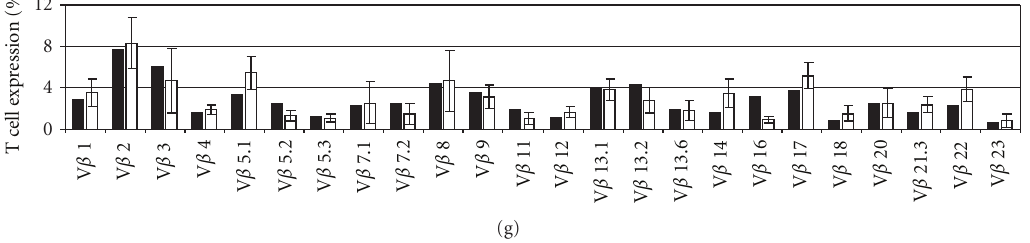
Figure 2: T-cell receptor (TCR) V β repertoire. Relative expression levels of 24 di ff erent TCR V β families in CD3 + cells (black bars) of pt1 (a), pt2 (b), pt3 (c), pt4 (d), pt5 (e), pt6 (f), and the mother of pt1 (g) compared with the relative expression of normal healthy controls (white bars) were obtained by FACS analyses. Normal control values were obtained using the IOTest Beta Mark TCR V β Repertoire Kit (Beckman Coulter). Table 2: Suggested immunological distinctions between SCID patients presenting with residual T lymphocytes of di ff erent origins. Origin of patient’s